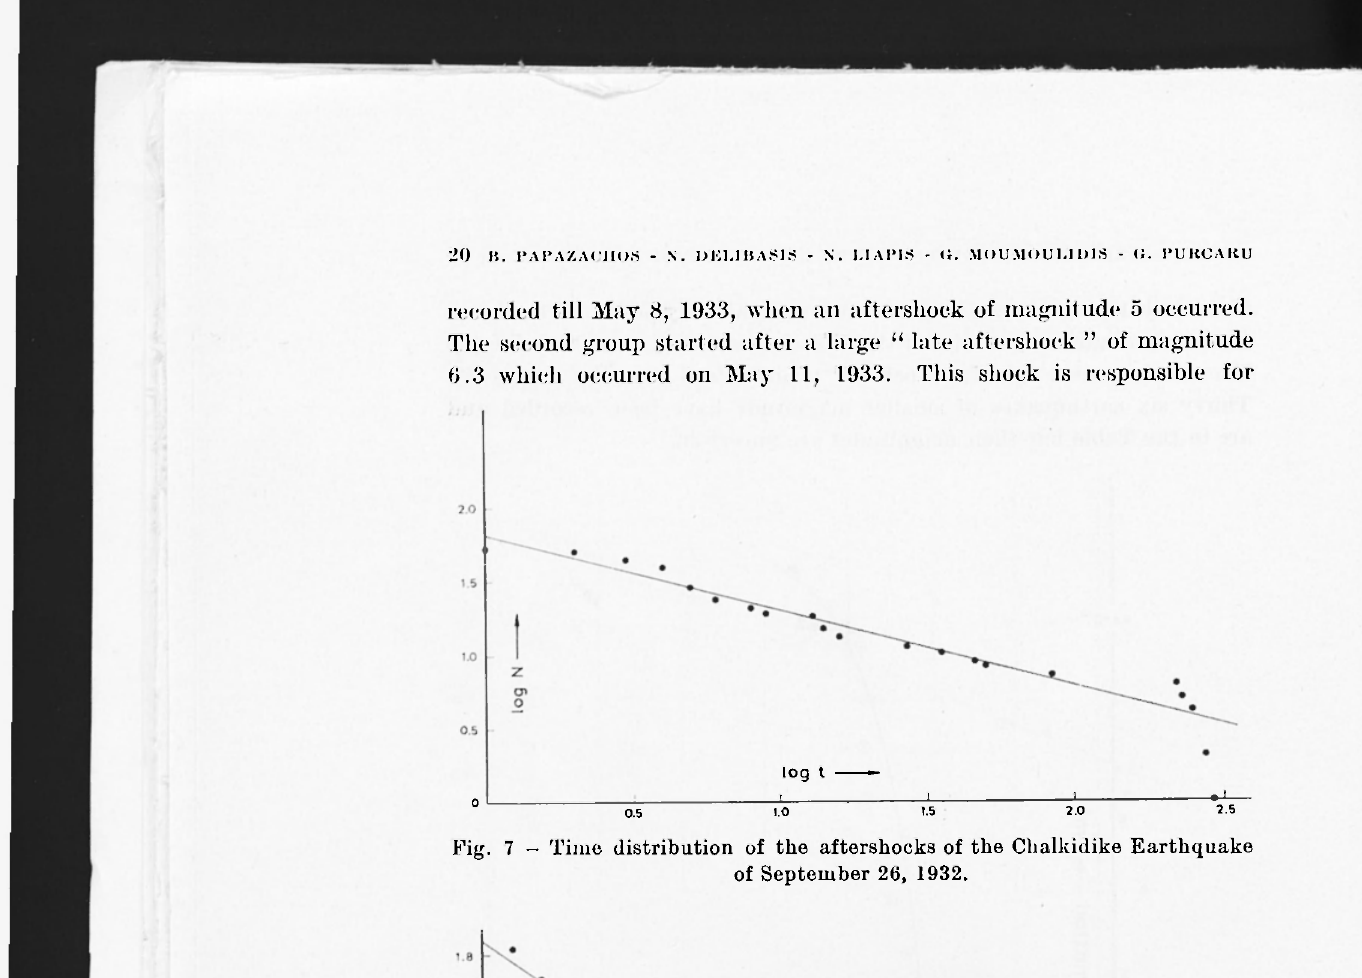
Fig. 7 - Time distribution of the aftershocks of the Chalkidike Earthquake of September 2(5, 1932.